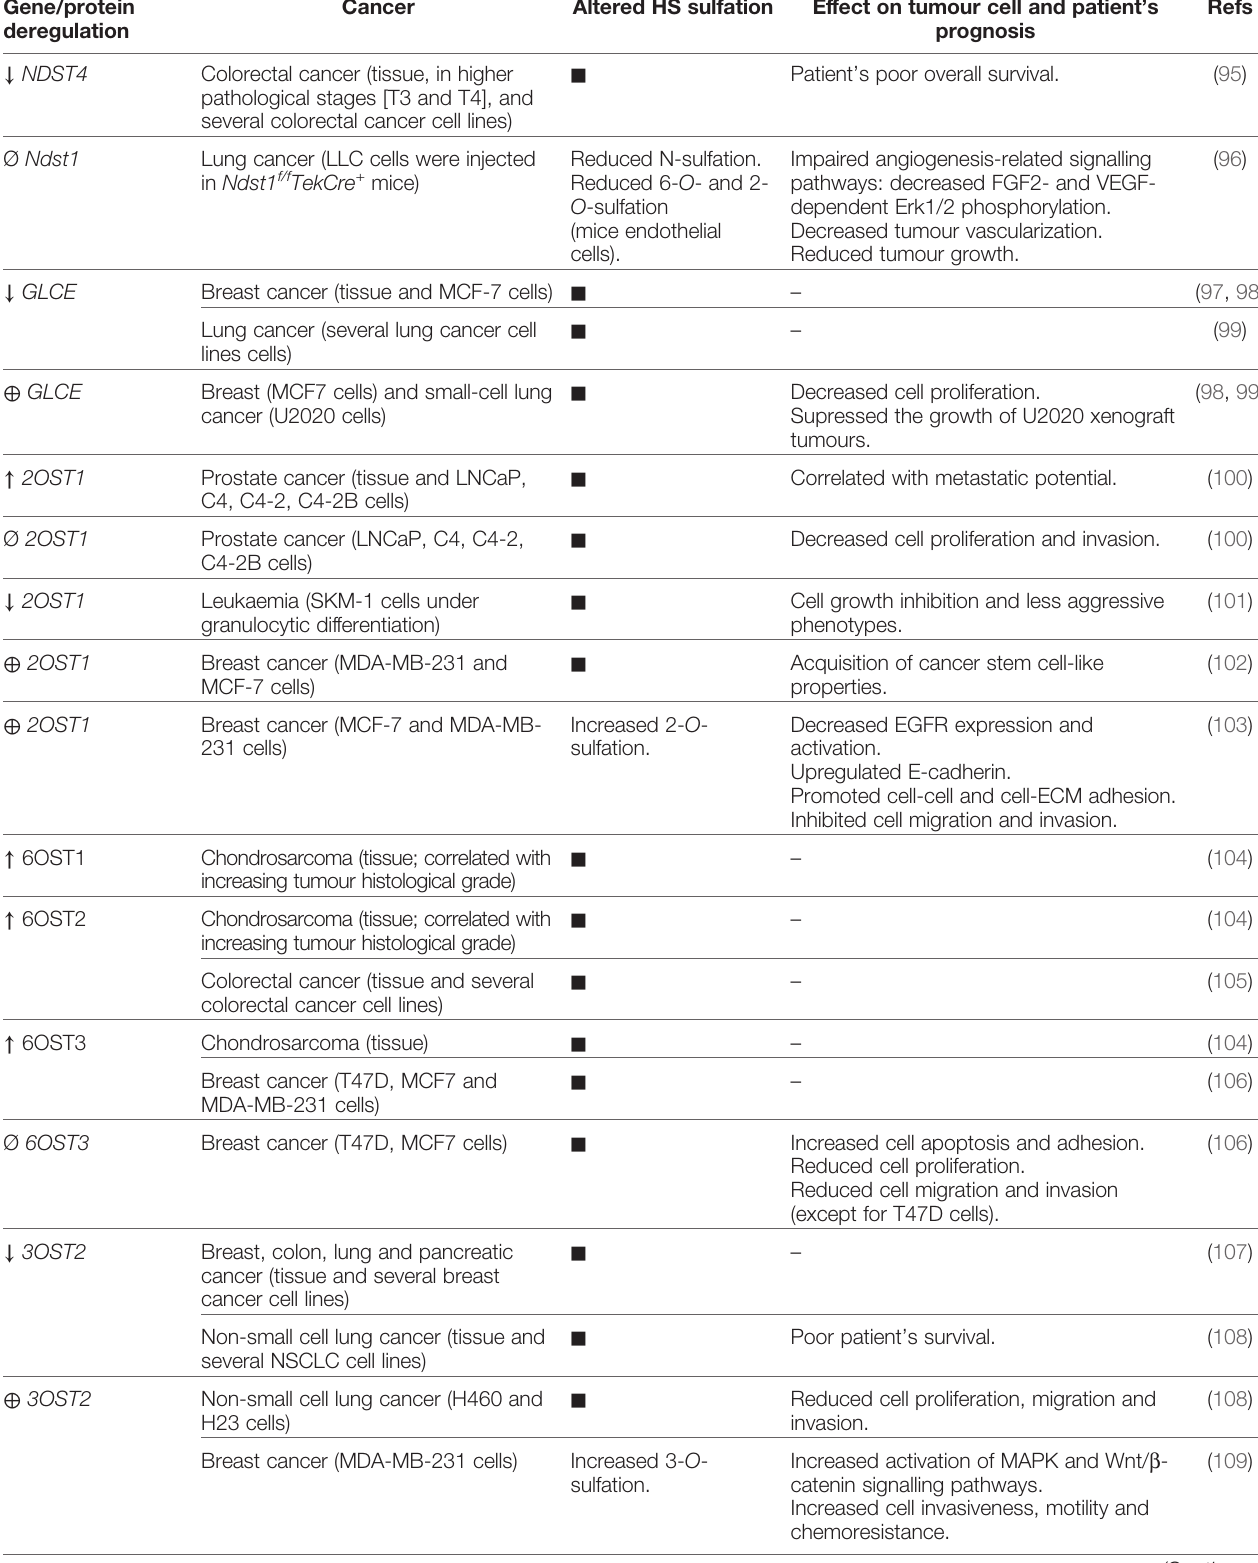
TABLE 1 | Aberrant expression of HS modifying enzymes on cancer and its effects on cellular features and patient ’ s prognosis. Gene/protein Cancer deregulation Colorectal cancer (tissue, in higher pathological stages [T3 and T4], and several colorectal cancer cell lines) Reduced N-sulfation. Reduced 6- O - and 2- dependent Erk1/2 phosphorylation. O -sulfation Decreased tumour vascularization. (mice endothelial Reduced tumour cells).